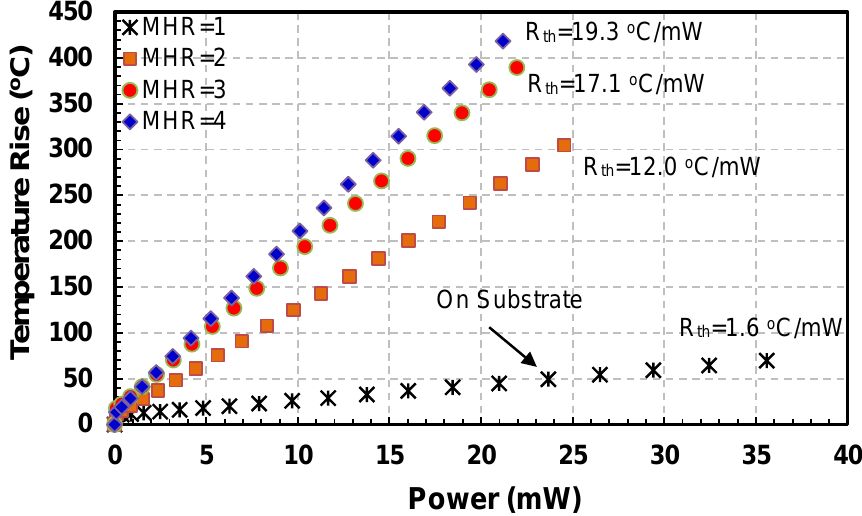
Figure 7. Power versus temperature rise curves for hot-film sensors FS1, FS3, FS5 and FS7 having square membranes: For FS1 sensor with MHR = 1 (having partially etched membrane), there is a negligible rise in sensor temperature. For FS3, FS5 and FS7 sensors with higher MHRs (i.e., MHR = 2, 3, 4, respectively), the temperature rise is significant, but its % increment between MHR = 2 to MHR = 3 and then from MHR = 3 to MHR = 4 reduces drastically.